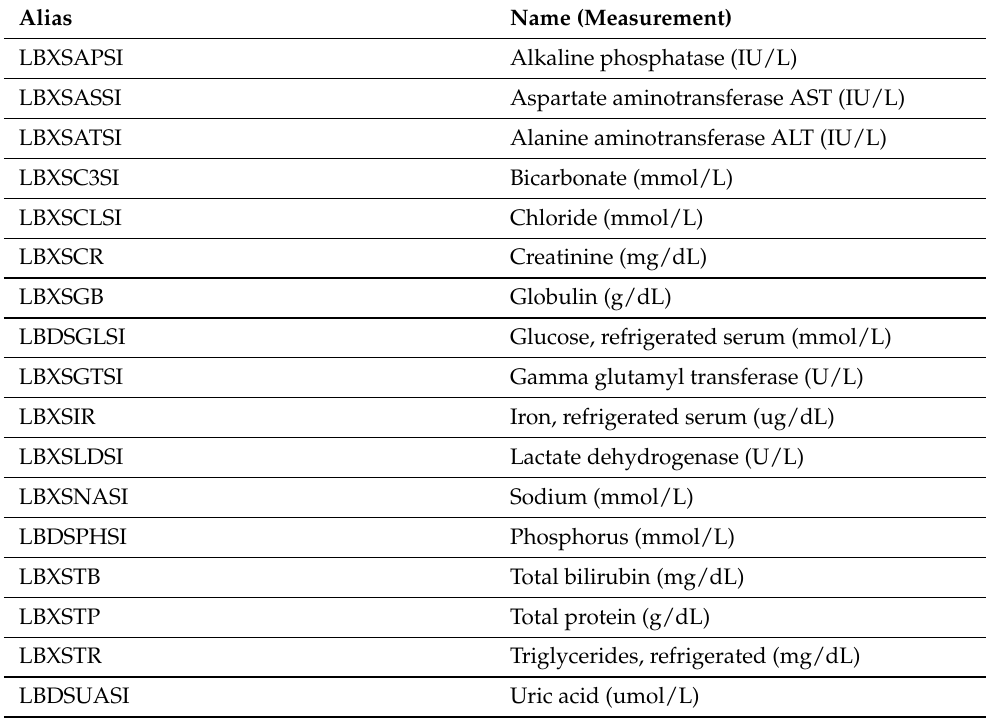
Table A1. Standard Biochemistry